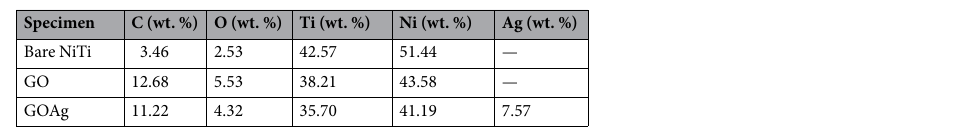
Table 1. Elemental analysis from energy-dispersive X-ray spectroscopy of the bare NiTi, GO-coated NiTi (GO), and GO/Ag-coated NiTi (GOAg) substrate. C = Carbon, O = Oxygen, Ti = Titanium, Ni = Nickel. Ag = Silver, and wt. % = weight